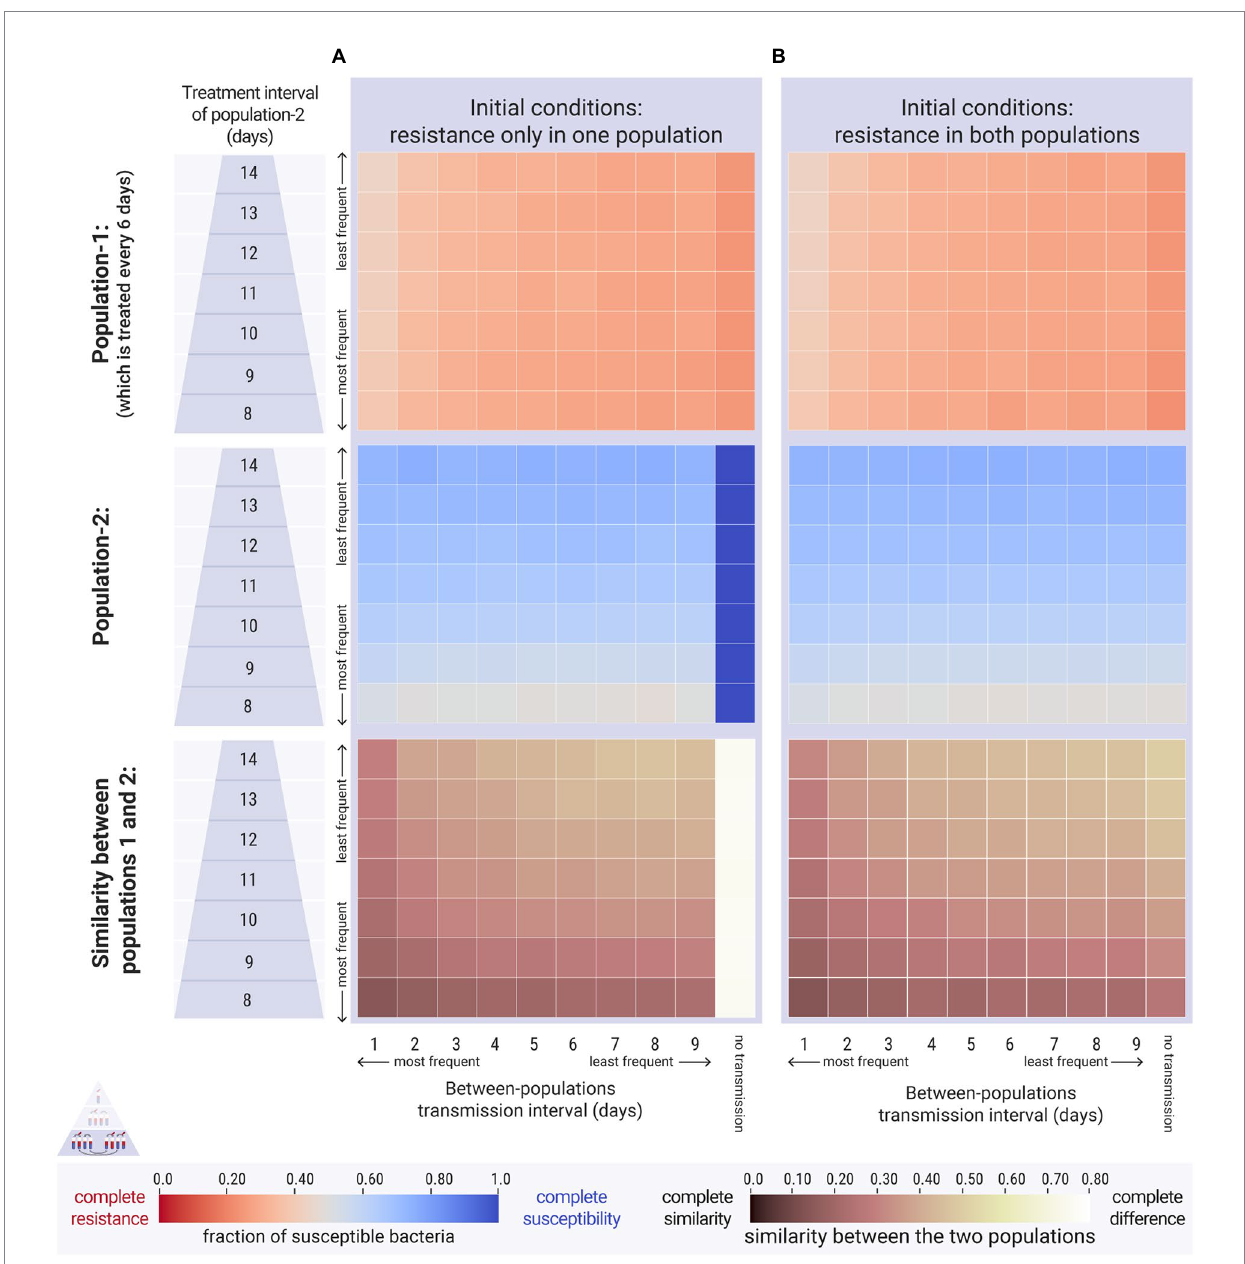
FIGURE 7 Results of the between-populations simulations. The first population was treated every 6 days ( 6 _ 1 I antim p = days). The second population was treated less often across a range of treatment intervals ( _ 2 I antim p , y -axis), ranging from 8 to 14 days. Within-population transmission was daily for both populations ( 1 I trans = day). We vary the between-populations transmission ( _ I between trans , x -axis). The relative fitness of the resistant strain is set to a high level, at 0.9 w